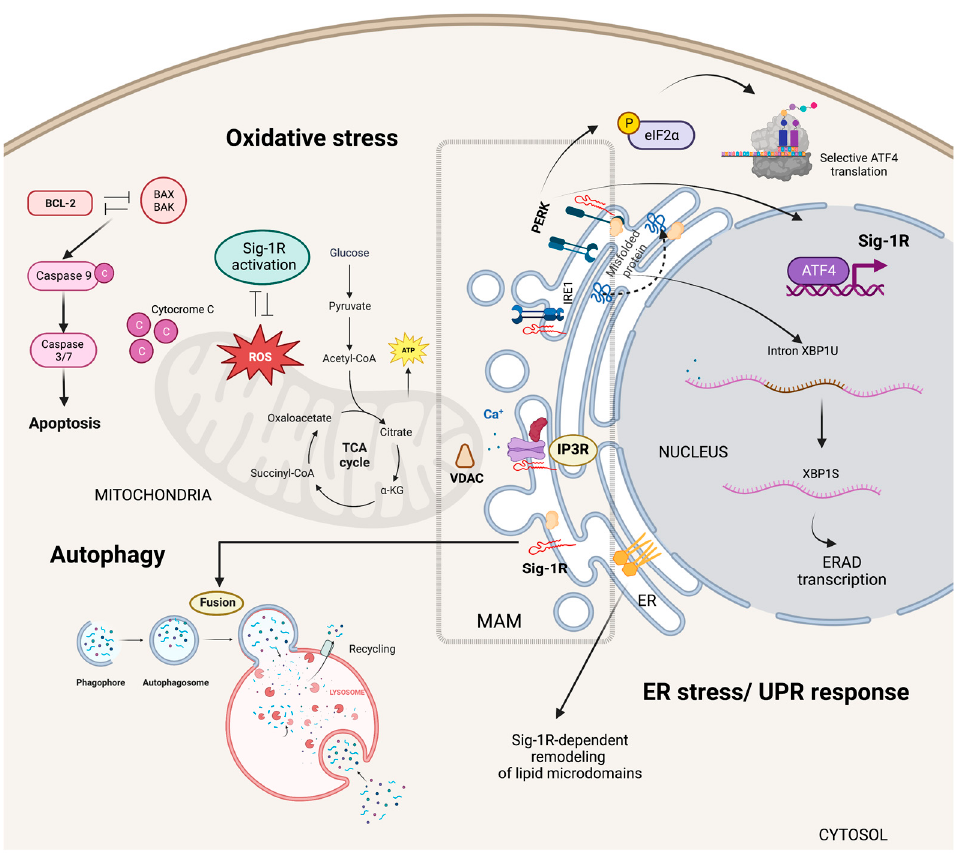
Figure 3. Sig-1R signaling in cytoplasmic organelles. Sig-1R is enriched at ER MAMs where microdomains at focal contacts between ER and mitochondria allow calcium release from the ER via IP3Rs into the mitochondria regulating calcium signaling between these two organelles. Sig-1R also plays a dual role in regulating oxidative stress responses and acts as an ER lipid scaffolding protein able to interact with and remodel cholesterol-rich microdomains. In response to ER stress, Sig-1R increases the calcium leak from the ER into the mitochondria to strengthen mitochondrial bioenergetics and enters a positive transcriptional loop that increases Sig-1R expression through the PERK/eIF2- α /ATF4 pathway. Sig-1R modulates the autophagosome-lysosome fusion step without altering PINK1/Parkin signaling or autophagosome biogenesis.